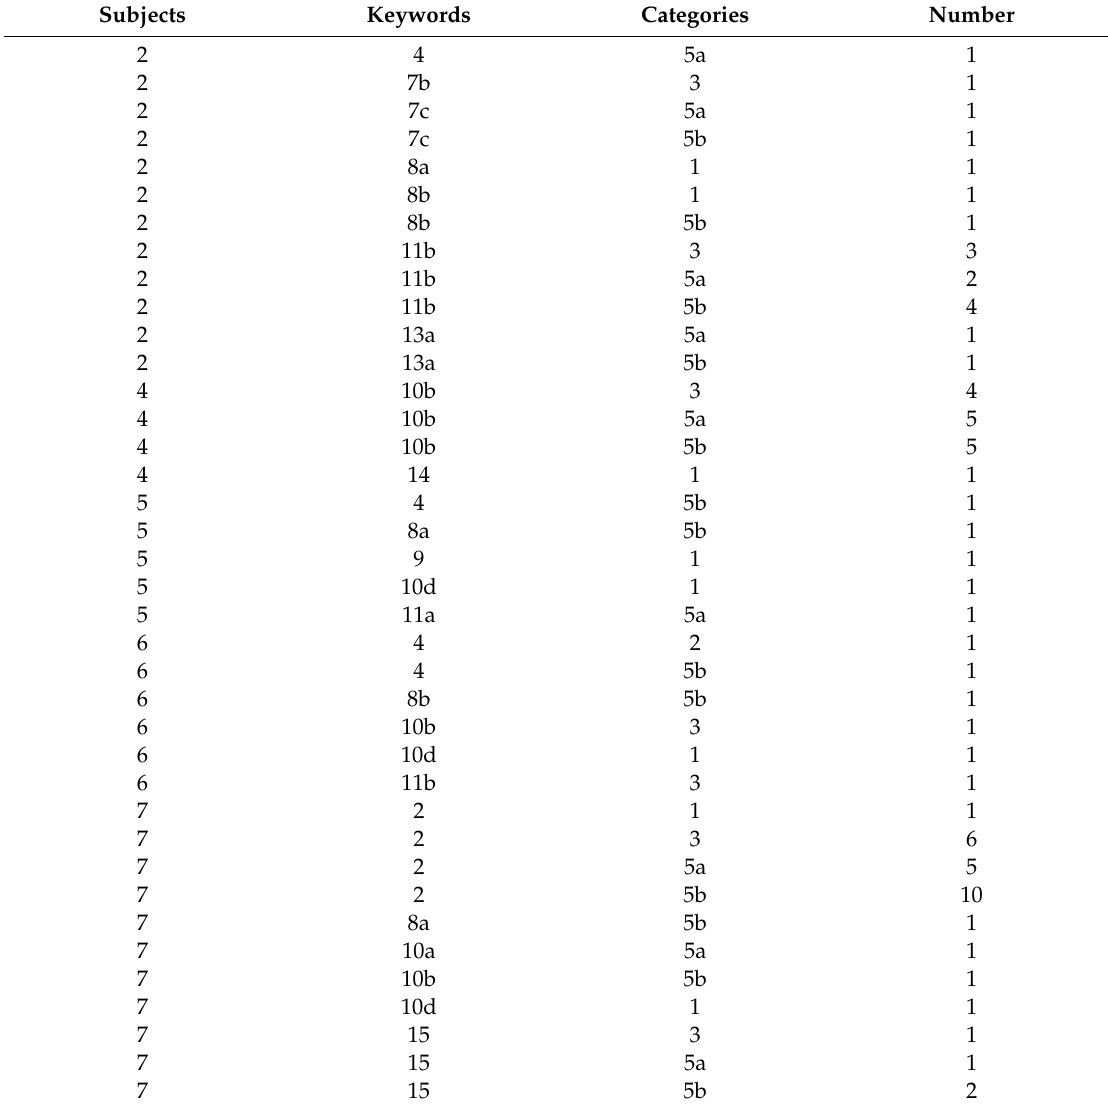
Table A5. Full results: